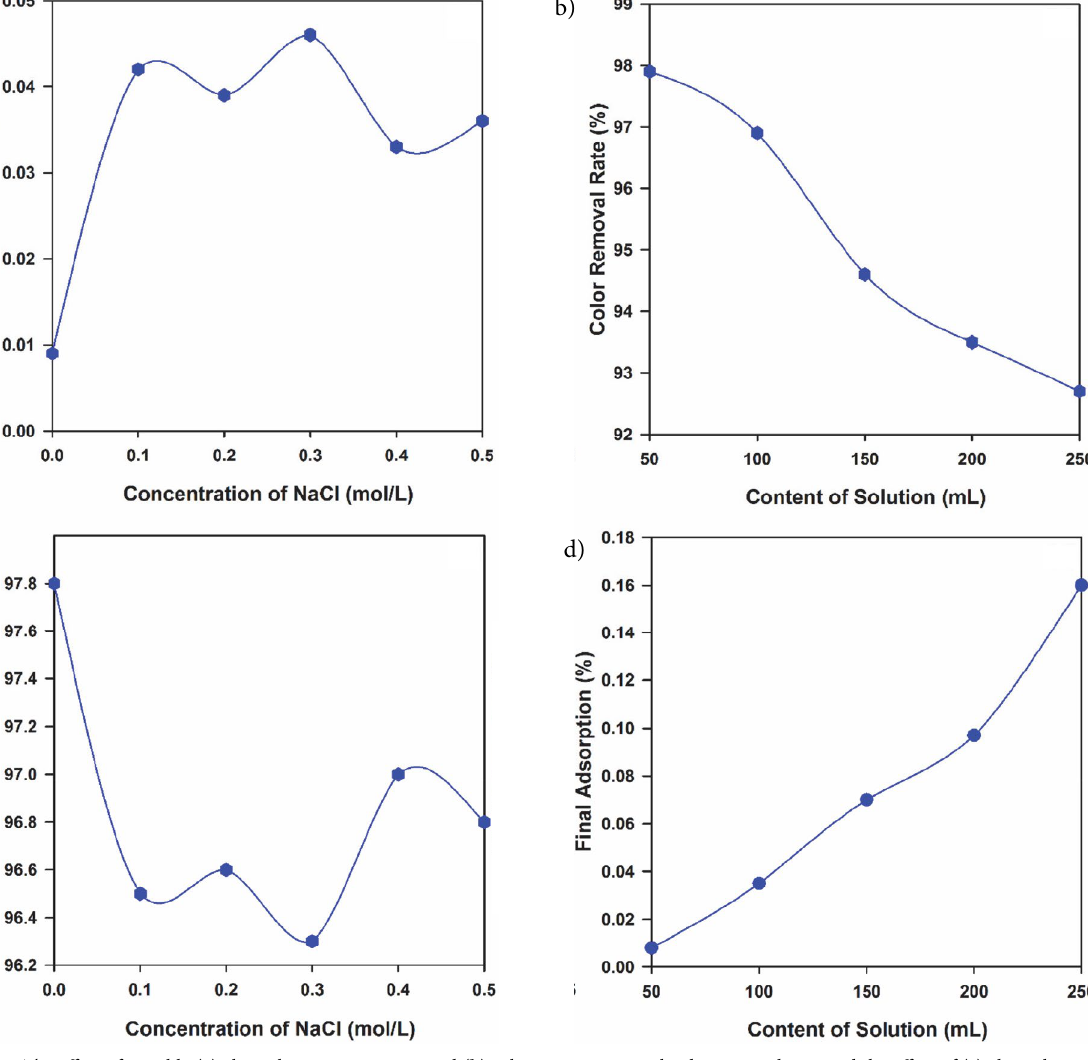
Figure 5. The effect of variable (a) electrolyte concentration and (b) solution content on the dye removal rate; and the effect of (c) electrolyte con- centration and (d) solution content on the final adsorption rate of Erythrosine